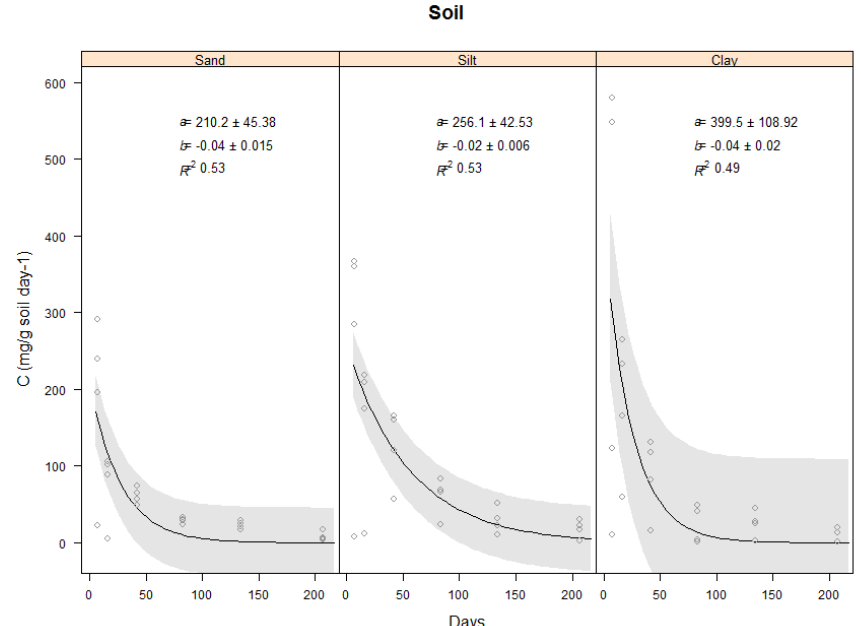
Figure 2. Carbon (mg C g soil − 1 day − 1 ) evolved from the soils (sand, silt, clay) without biomass addition during 206-days decomposition period. Where soils only incubated at 25 ◦ C constant temperature. Plots show the raw data (o), a fitted exponential model ( − ) and 95% confidence bands. Values of the intercept (a), the slope (b) and Coefficient of determination (R 2 ).